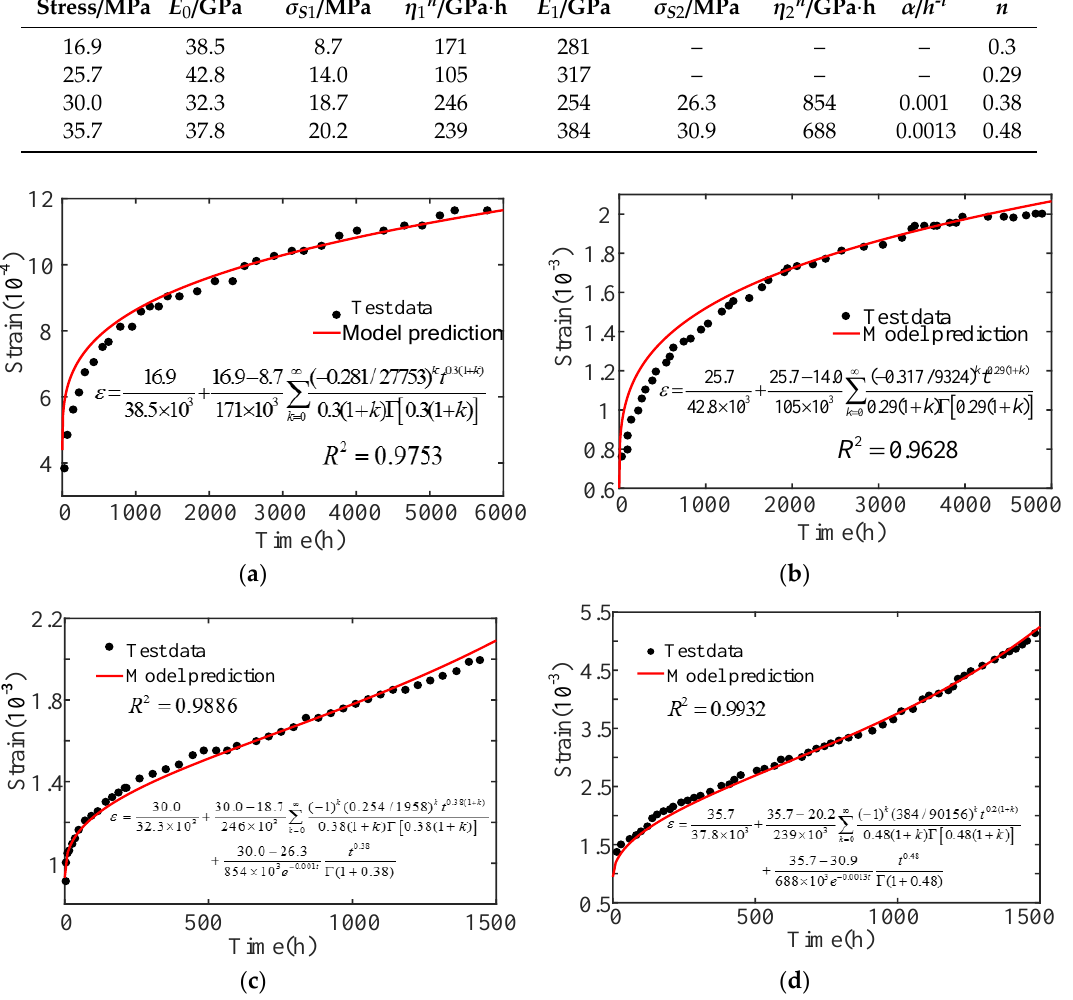
Figure 6. Fitting curves of test curves and built models. ( a ) σ = 16.9 MPa; ( b ) σ = 25.7 MPa; ( c ) σ = 30.0 MPa; ( d ) σ = 35.7 MPa.